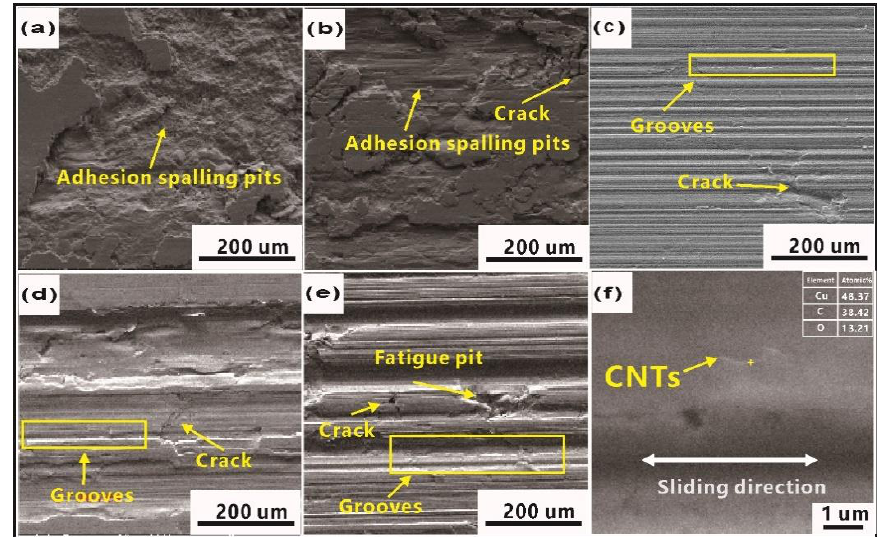
Figure 8. SEM images of worn surface under dry friction conditions of Cu/CNT composites containing: ( a ) 0, ( b ) 0.3, ( c ) 0.6, ( d ) 1.2, and ( e ) 1.8 vol.% CNTs and ( f ) highly magnified image of worn surface.